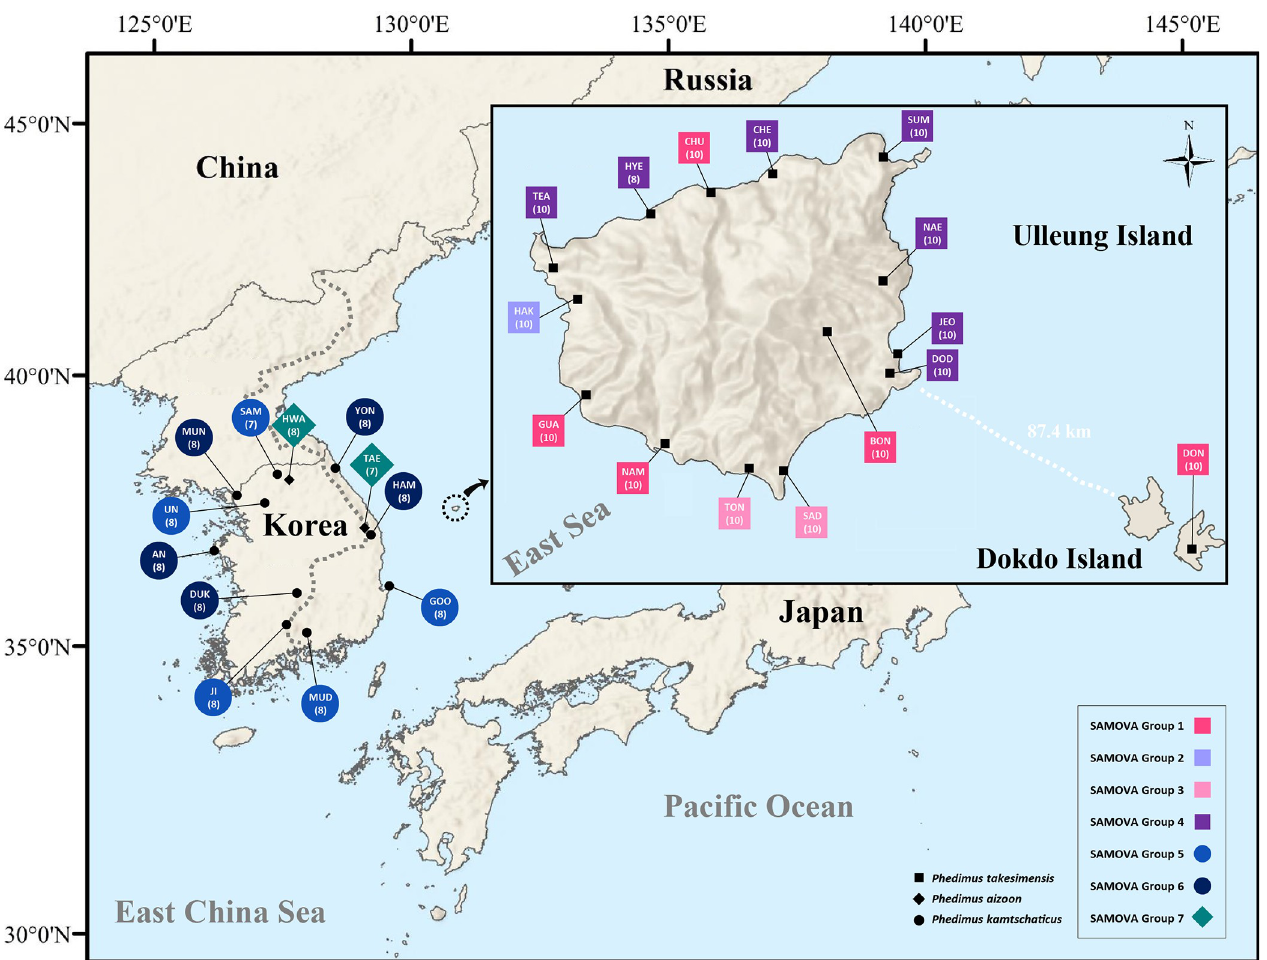
Fig 7. Spatial analysis of molecular variance (SAMOVA) grouping. Shapes and colors represent the different groups used in the SAMOVA analysis. Groups 1–4 represent Phedimus takesimensis on Ulleung Island. The two continental progenitor species are represented by Groups 5 and 6 ( P . kamtschaticus ) and Group 7 ( P . aizoon